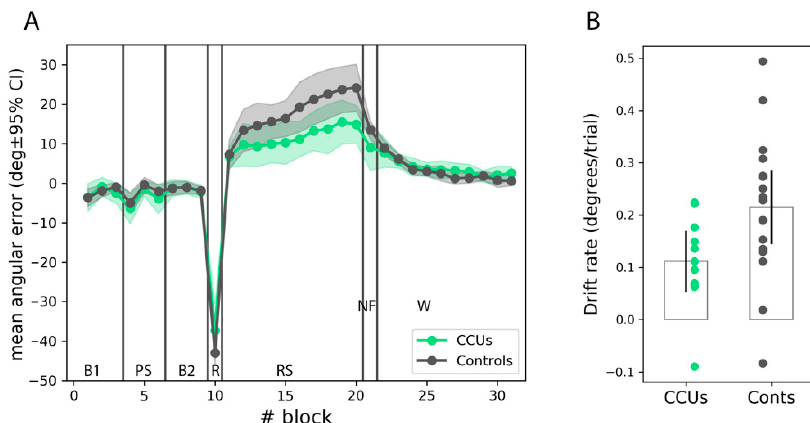
Figure 2. Motor adaptation in chronic cannabis users (CCUs) and control participants (Conts). ( A ): Evolution of the average error. Vertical lines separate different phases of the experiment, indicated by the labels: B1, first baseline period; PS: practice strategy; B2: second baseline period; R: rotation; RS: rotation plus strategy; NF: no feedback washout; W: regular washout. ( B ): Rate of error increase in the RS phase. Shaded areas and error bars indicate the 95% confidence interval of the